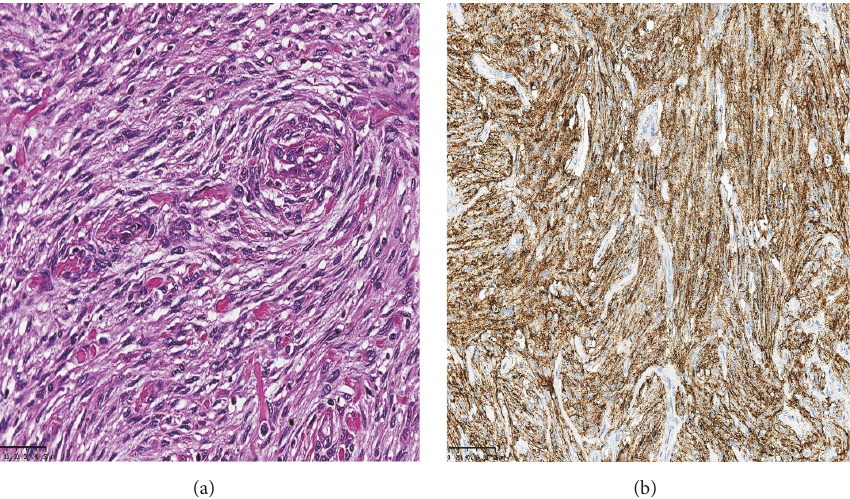
Figure 2: Histologic section of the liver mass. (a) Sections of the liver showing sheets of spindle cells with a whorled pattern in a collagen rich matrix (hematoxylin-eosin, 200x). (b) The neoplastic cells are positive for epithelial membrane antigen by immunohistochemistry (200x).